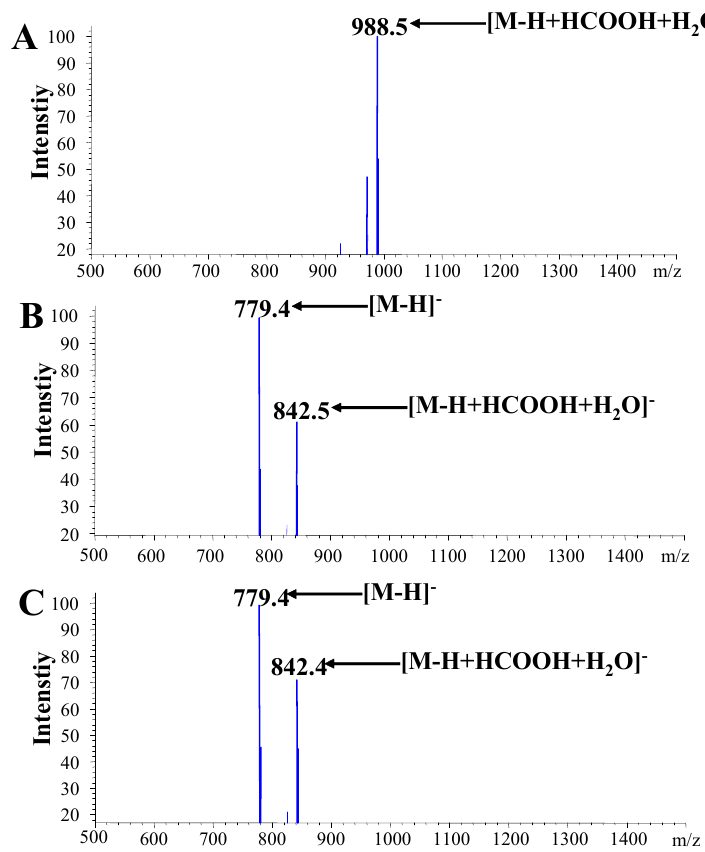
Figure 4 . ESI/MS ( − ) spectra of saikosaponin c (A); saikosaponin a (B); saikosaponin d